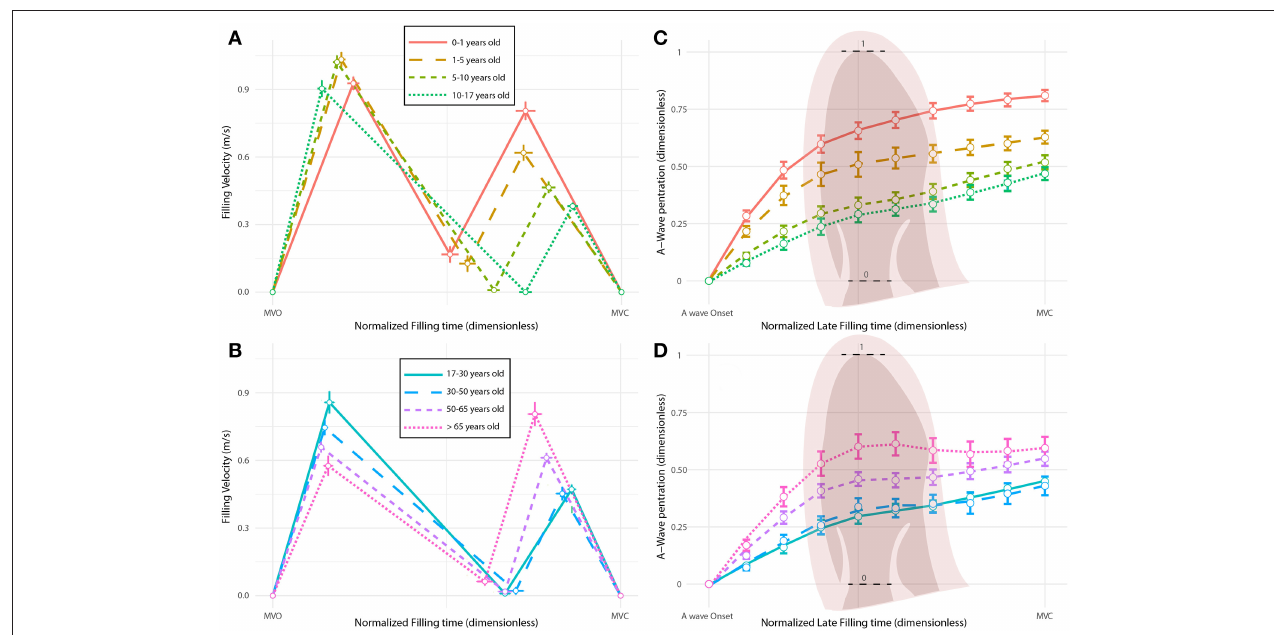
FIGURE 5 | Age-related changes in filling profiles and late-filling wave penetration. ( A,B) E and A wave patterns during filling. Horizontal axes represent normalized filling time from mitral valve opening (MVO) to mitral valve closing (MVC). (C,D) Tracking of the A-wave penetration along the LV long axis during the late filling phase, from A-wave onset to mitral valve closing (MVC). Horizontal axes represent the normalized late filling time and vertical axes the normalized long-axis length from the base to the apex. Colors account for age